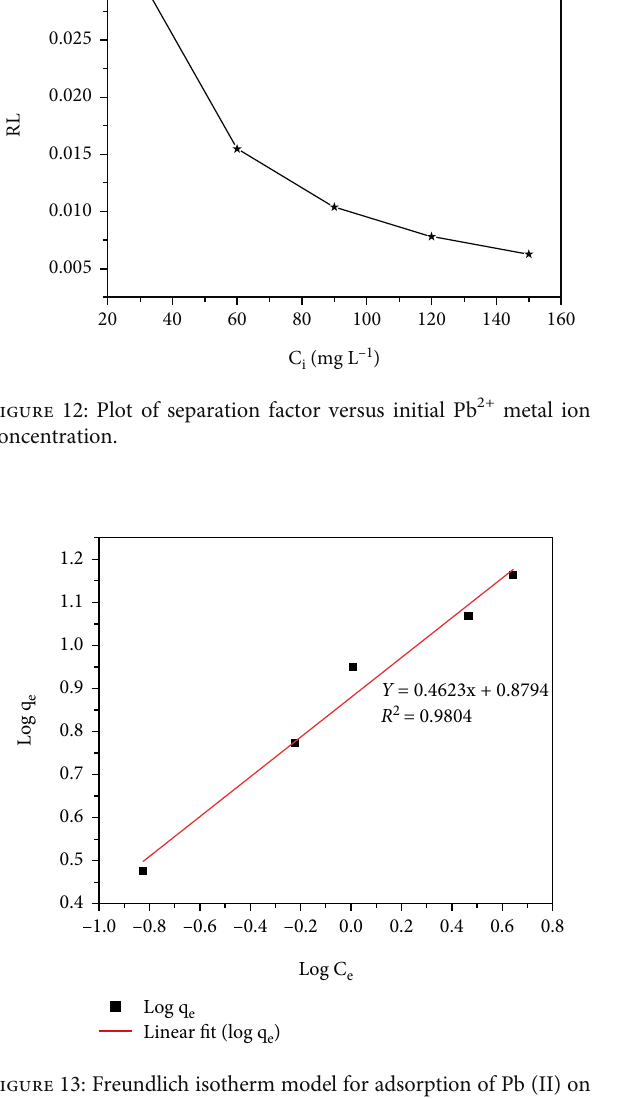
( 1/ K L ∗ q m ). q m and K L were calculated to be 16.891 and 1.059, respectively.